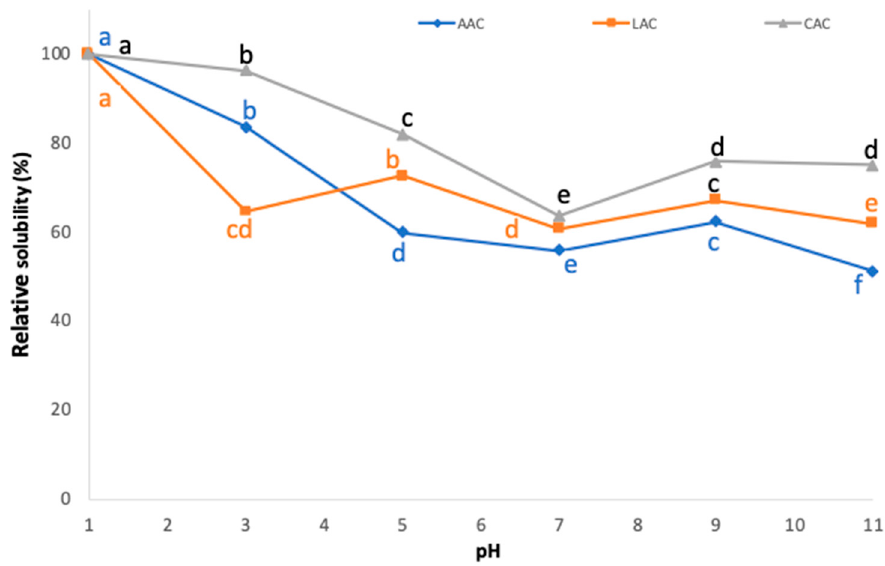
Figure 5. Effect of solubility of needlefish skin collagens extracted with different acids at different concentration of NaCl. AAC: acetic acid collagen; LAC: lactic acid collagen; CAC: citric acid collagen. Different letters indicated significant differences between the samples.